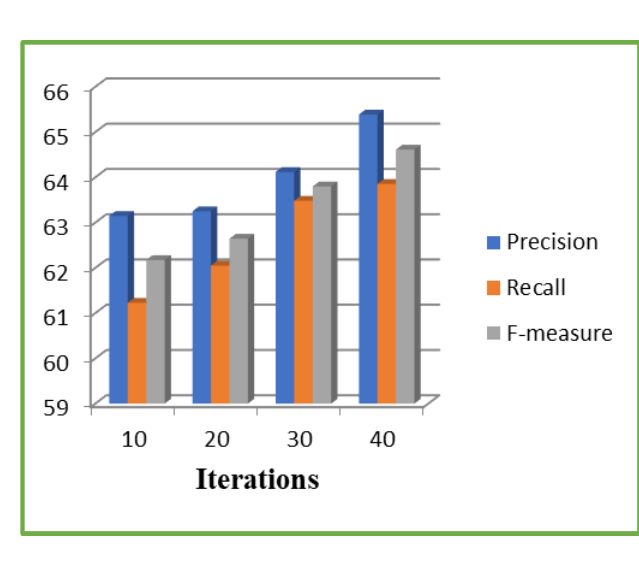
Figure 4. Precision, Recall and F-Measure values for the proposed CS-ABC technique.